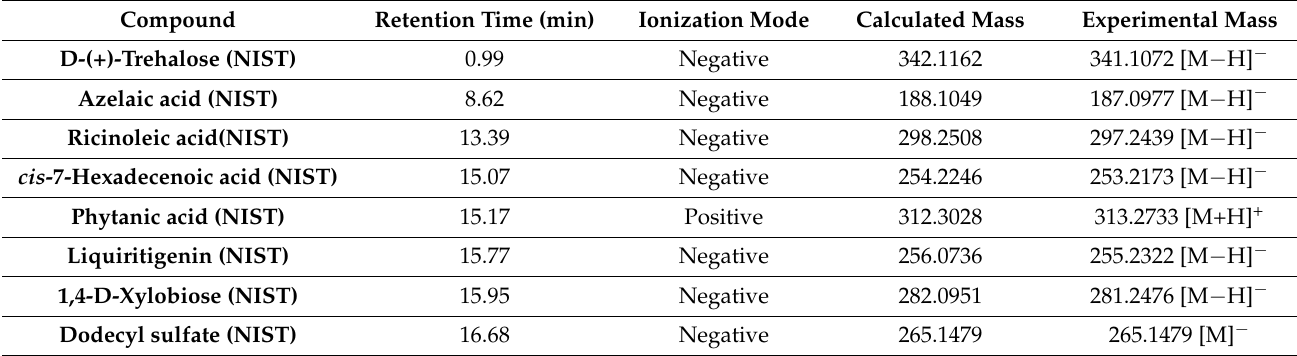
Table 2. LC-MS analysis of methanolic extract of O. baccatus roots.